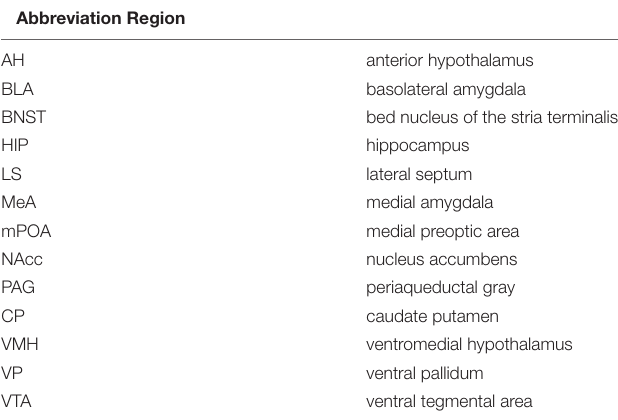
TABLE 1 | List of all thirteen regions associated with the social decision-making network, along with the abbreviations of each regions. Abbreviation